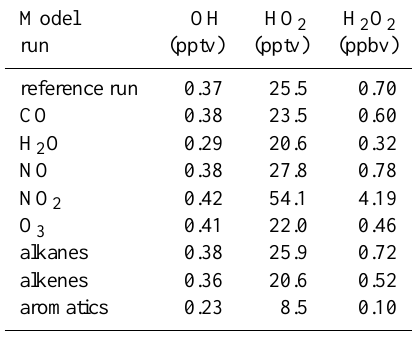
Table 3. Calculated concentrations of OH, HO 2 , and H 2 O 2 for sen- sitivity analyses when the concentration of each trace gas in col- umn 1 has been reduced by half.